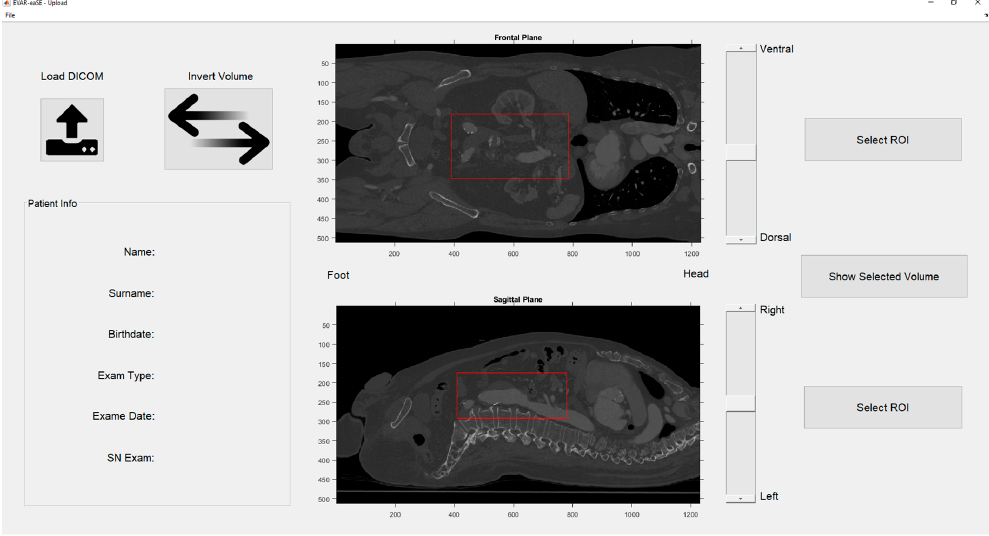
Figure 2. Graphical user interface of Upload Window (UW).